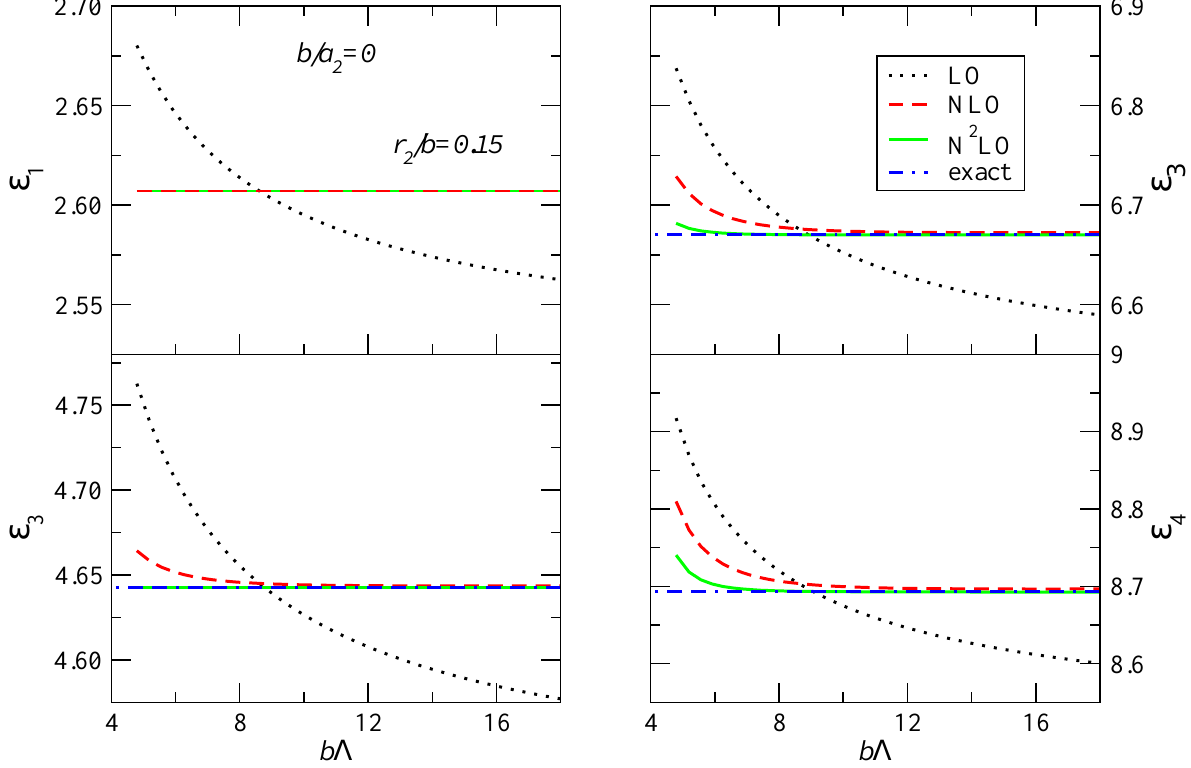
Fig. 3. Running of the energies of the first four excited states for two-trapped particles at unitarity with a non-vanishing physical range, b / a 2 = 0 . 15.The coupling constants are fixed so that the ground-state, and the first and second excited states given by Eq. (11) are fixed in the appropriate order: at LO, ε 0 , at NLO, ε 0 and ε 1 , and at N 2 LO, ε 0 , ε 1 and ε 2 respectively.